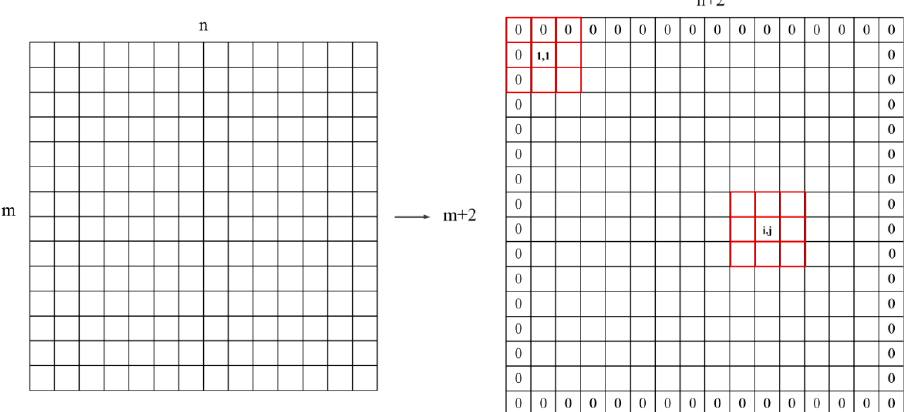
Figure 2. Data point generation. The left is the original image, the right is the expanded image, and the red box marks the selection method of data points.